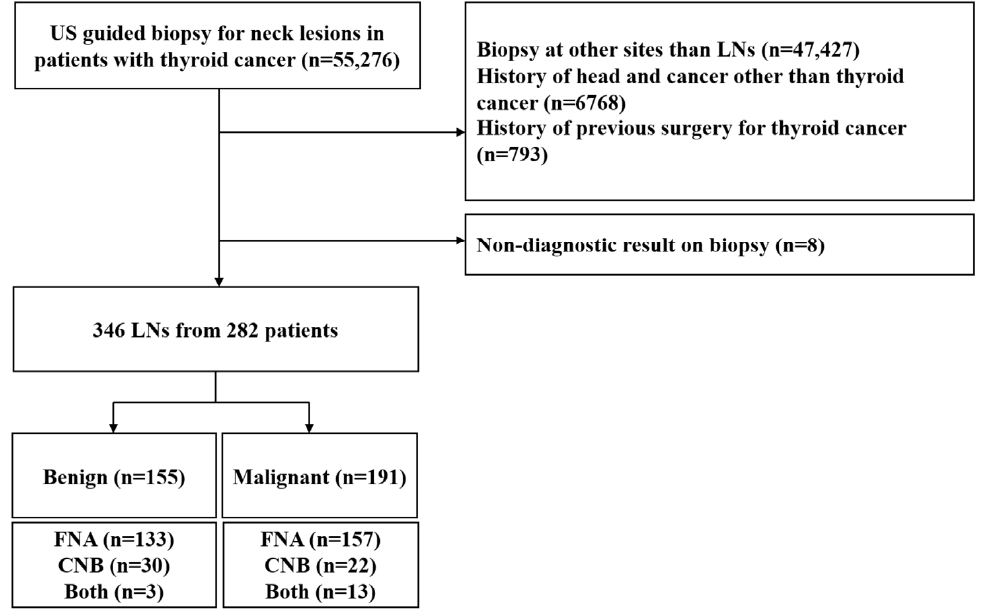
Figure 2. Flowchart of the study group. US, ultrasonography; LN, lymph node; FNA, fine-needle aspiration; CNB, core needle biopsy. aspiration; CNB, core needle